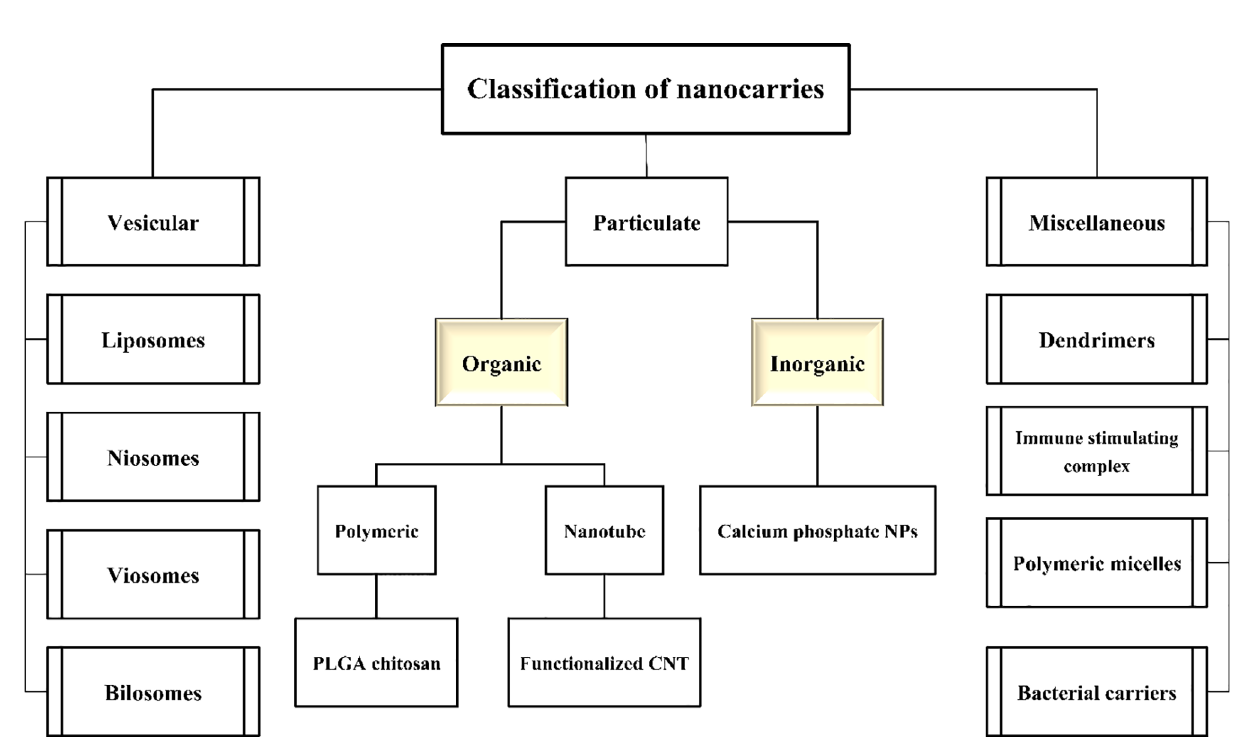
FIGURE 1 | Flowchart of nanocarriers ’ classi fi